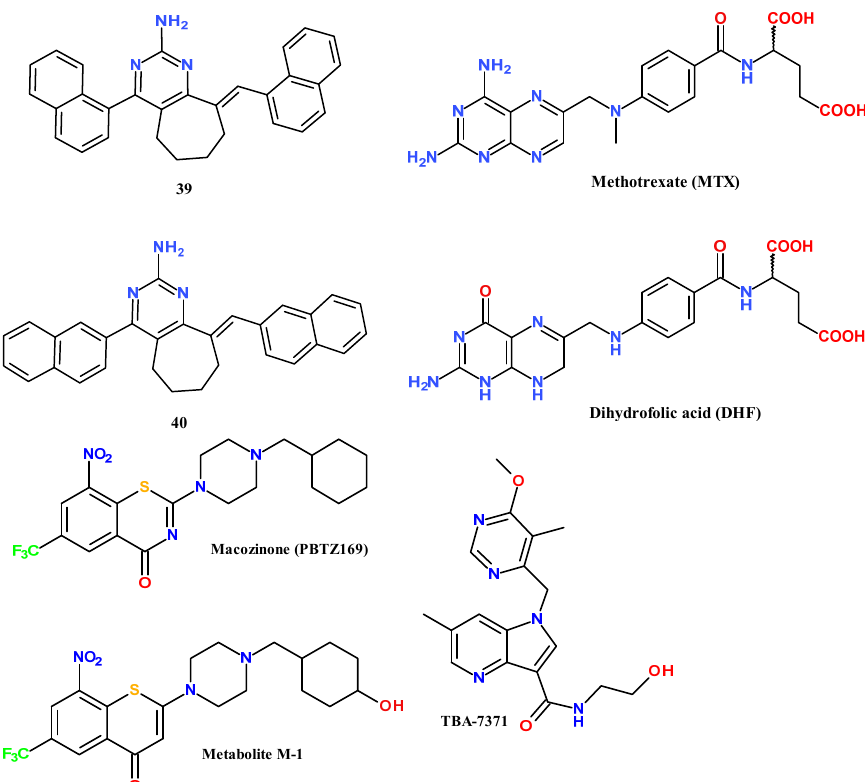
Figure 2. The best-docking-scored reference compounds from [6,24] and other known inhibitors for the mycobacterial DHFR, such as methotrexate (MTX), macozinone ( PBTZ169 ), and TBA-7371 . Heteroatoms and key functional groups are color-coded.